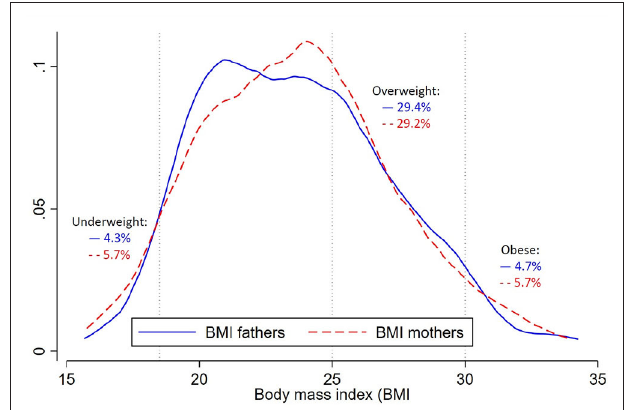
FIGURE 1 | Density plot for the body mass index (BMI; in kg/m 2 ) and prevalence of underweight, overweight and obesity of fathers (solid blue line, n = 445) and mothers (dotted red line, n = 600). Underweight is defined as BMI < 18.5, overweight as BMI 25–29.9 and obesity as BMI ≥